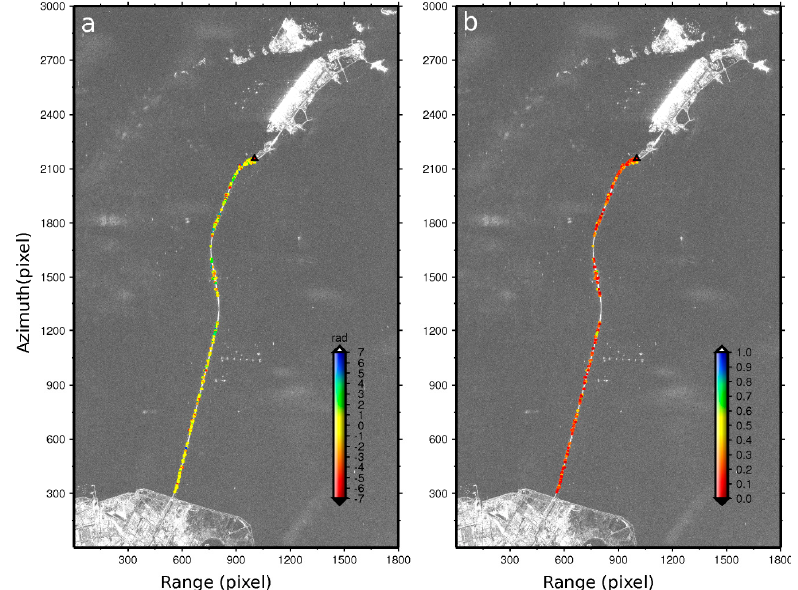
Figure 4. ( a ) The selected temporarily coherent points (TCPs) in the Donghai Bridge, where the color indicates the difference of interferometric phases of the resampled TCPs between the conventional and TCP polynomials; and ( b ) the selected TCPs in the Donghai Bridge, where the color indicates the improvement of the coherence of the resampled TCPs from the TCP polynomials to that from the conventional polynomials. The figure is plotted in the SAR coordinate system.